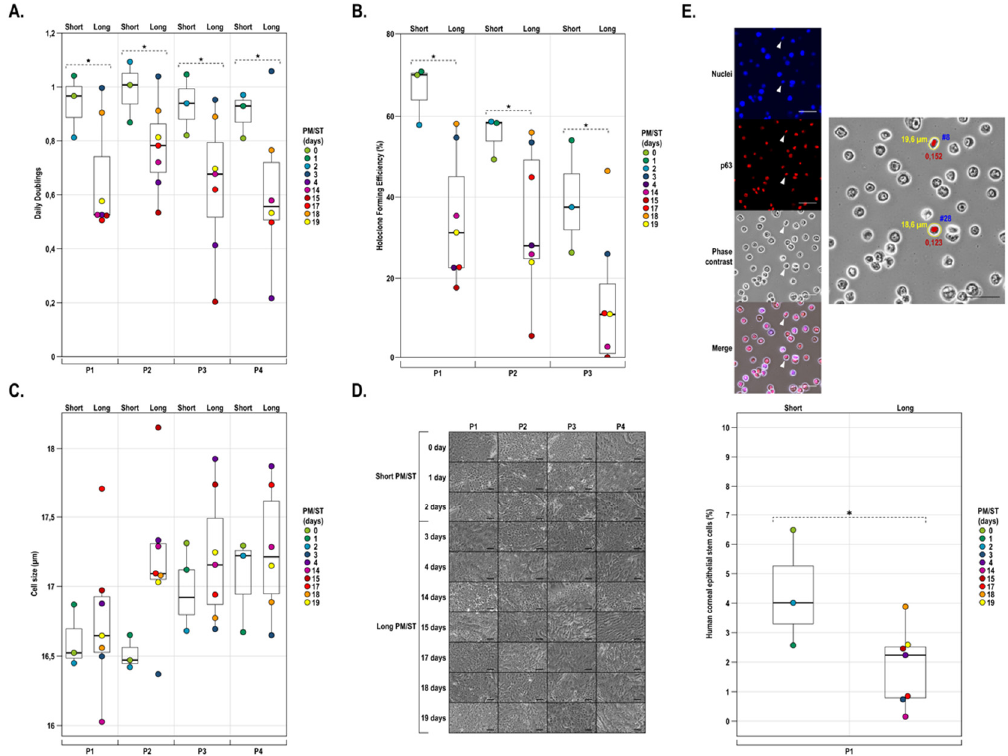
Figure 3. Proliferative properties, holoclone-forming capacity, cell size, morphology, and stem cell analysis of hLECs with short or long PM/ST. ( A ) hLECs isolated from donor eyes with different PM/STs (short PM/ST: 0, 1, and 2 days; long PM/ST: 3, 4, 14, 15, 17, 18, and 19 days) were cultured until P4. Graph representation of the average growth rates calculated as the number of population doublings per day. ( B ) Graph representation of the holoclone-forming percentage calculated from the colony-forming cells present in the different hLECs populations cultured at P1, P2, and P3. The number of holoclones can be used as a surrogate for the evaluation of the number of stem cells contained in the culture. ( C ) Average cell size in μ m. ( D ) Morphology by phase contrast microscopy of hLECs cultured at passage P1 to P4. Scale bars: 200 μ m. ( E ) Top panel: One microscopic field showing the detection of stem cells on spread cells. Left pictures are nuclei stained with Hoechst, p63, phase contrast, and merging of the last two (stem cells are identified by arrowheads). On the right, detection of two corneal epithelial stem cells (shown in red) and their respective size (indi- cated in yellow) by picture analysis of fluorescence intensity of p63 labeling with CellProfiler soft- ware (staining > 0.120, size < 20 μ m). Bottom panel: graph representation of the percentage of corneal epithelial stem cells in different hLECs populations at P1. Scale bars: 50 μ m. p -value: * < 0.08. Colony-forming efficiency (CFE) was also evaluated at passages P1, P2, and P3. SPM/ST hLECs generated more colonies per seeded cell than LPM/ST hLECs (Figure 3B). In ad- dition, the holoclone percentages for SPM/ST hLECs relative to LPM/ST hLECs were higher at all passages . A tendency could be detected ( p -value: 0.0742) and differences were maintained over passages in culture (P1 to P3). Cell size and morphology can be important biomarkers of the differentiation state and proliferative potential. Indeed, less differentiated hLECs are characterized by a smaller size and a high nucleus-to-cytoplasm ratio while differen- tiated hLECs have a smaller nucleus-to-cytoplasm ratio. They were present in the cultures together with colonies comprising more differentiated cells. Given that the epithelial cell size increases upon terminal differentiation [64], the average hLECs size was analyzed for the 10 populations at each passage. Figure 3C shows that the average cell size suddenly increased at P3 for the SPM/ST hLECs and P2 for the LPM/ST hLECs. With the only exception of cells at P2, no statistically significant differences were detected in the cell size between the SPM/ST hLECs and LPM/ST hLECs groups at all passages ( p -value > 0.1). No obvious differences were observed in the cell morphology between hLECs with different PM/STs over cell